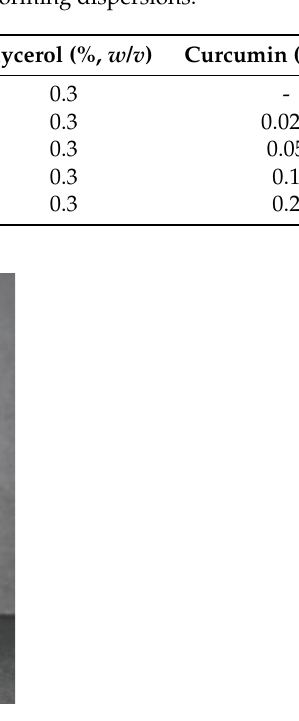
Table 1. Film nomenclature and final formulation of film-forming dispersions.